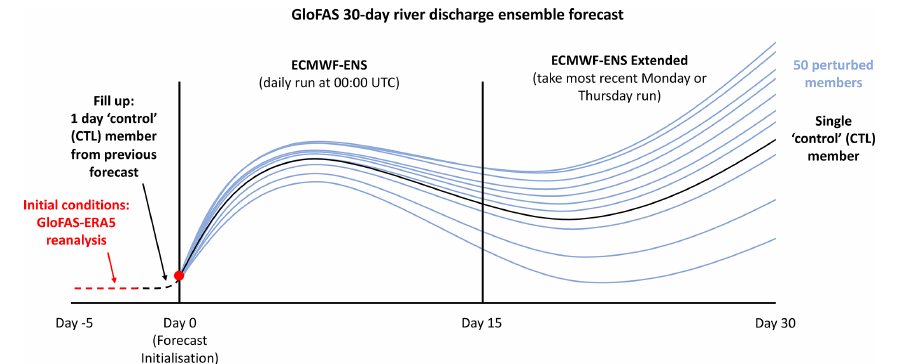
Figure 2. Schematic of a single GloFAS 30d real-time river discharge ensemble forecast initialised at day 0 for GloFAS version 2.1/2.2.